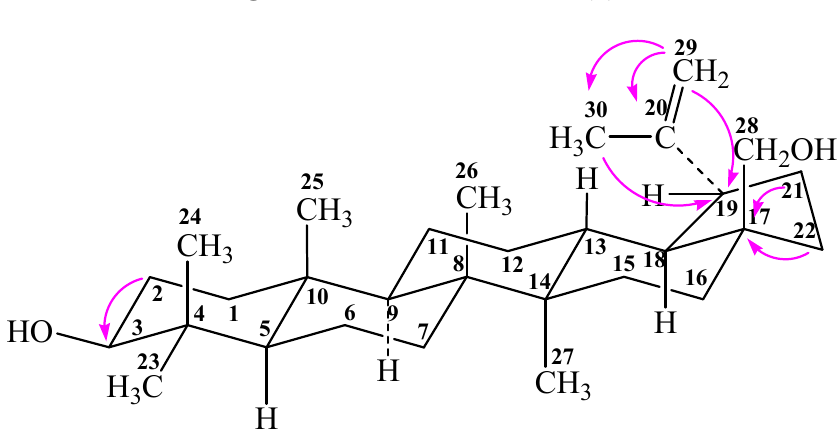
Figure 1. Structure of betulin ( 1